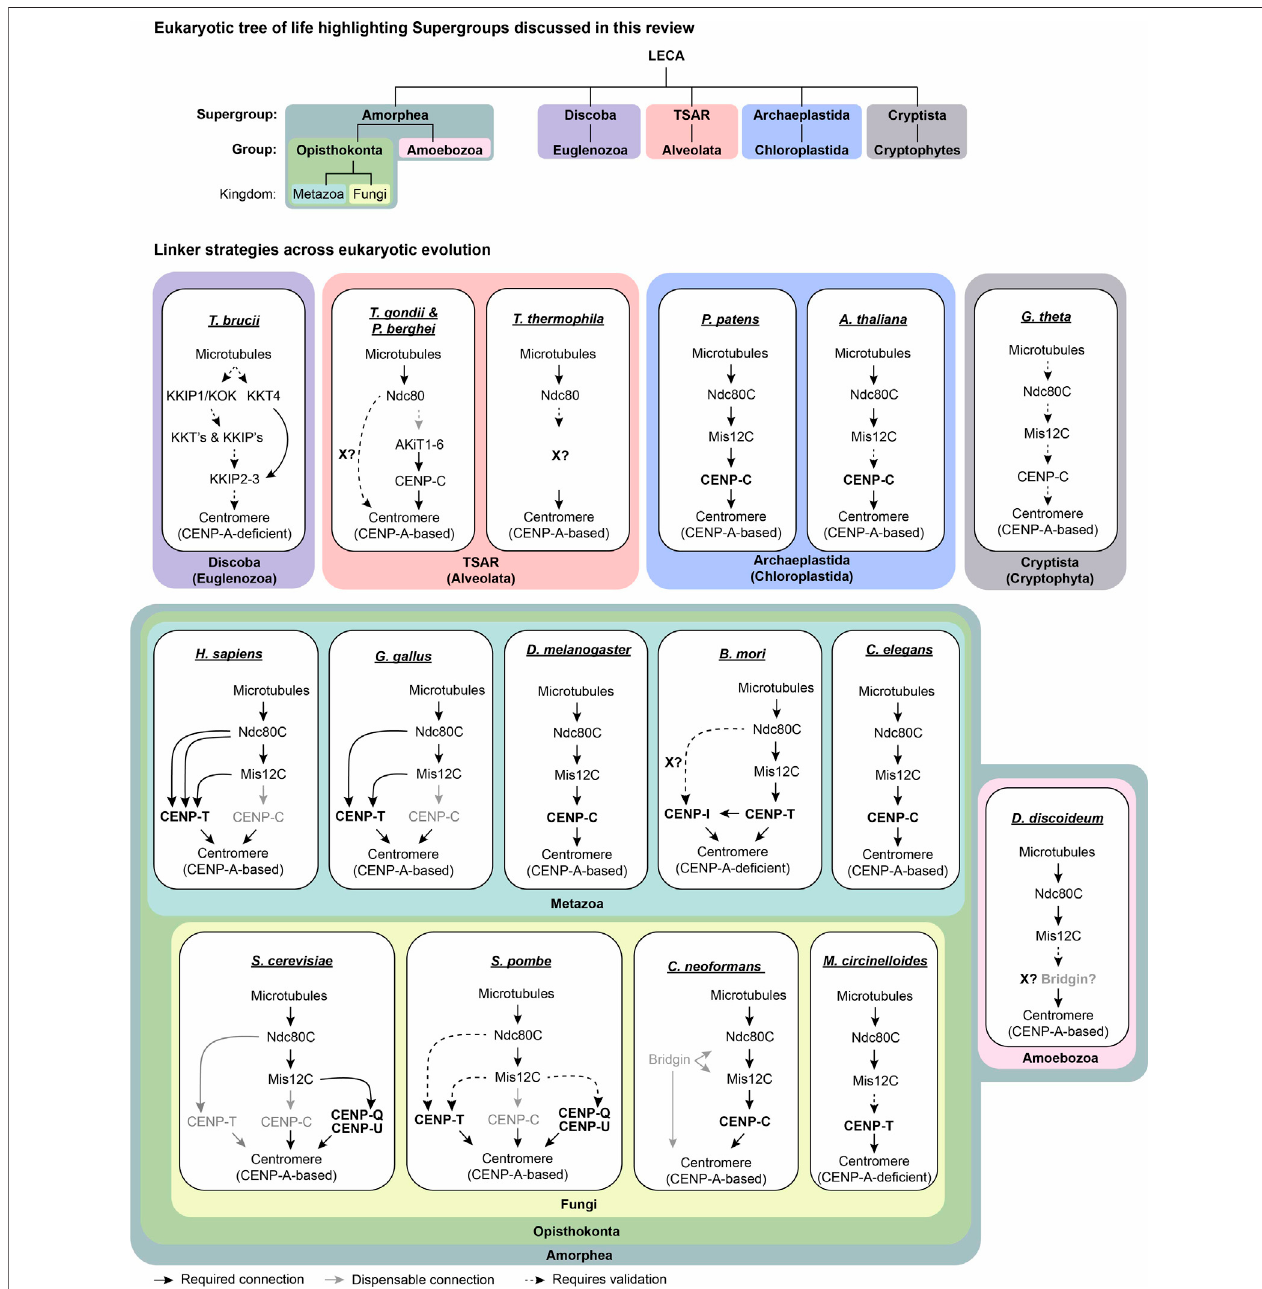
FIGURE 3 | Linker strategies used across eukaryotic evolution to recruit the near-ubiquitous outer kinetochore. (Top) A cartoon highlighting the phylogenetic relationship between supergroups of representative species described in the bottom panel. (Bottom) The connection between the outer kinetochore centromeric chromatin across representative species is highlighted. The major linker pathway protein is highlighted in bold. Phylogenetic groups are mentioned in brackets where applicable. Names of kinetochore homologs are presented in the vertebrate format.